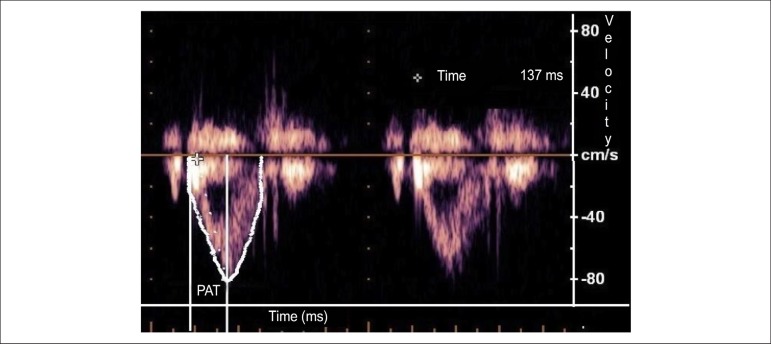
Pulsed-wave Doppler of pulmonary artery (PAT: pulmonary acceleration
time = interval from onset of pulmonary flow to peak velocity;
shorter acceleration time = higher pulmonary arterial pressure)